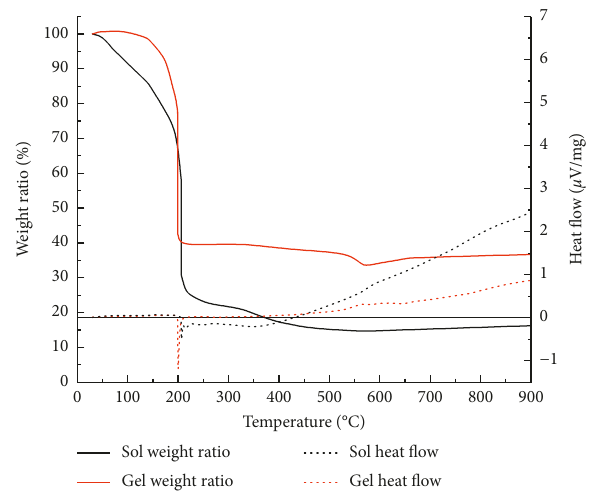
Figure 1: TG-DTA result: weight ratio and heat flow of the sol and